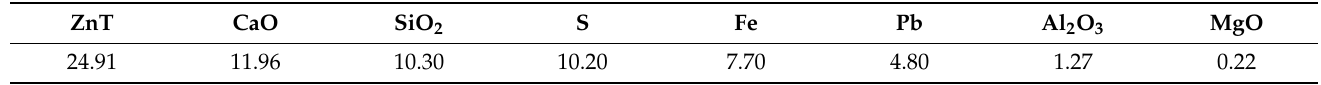
Table 1. The main chemical components of complex zinc ore (mass fraction, wt-%).